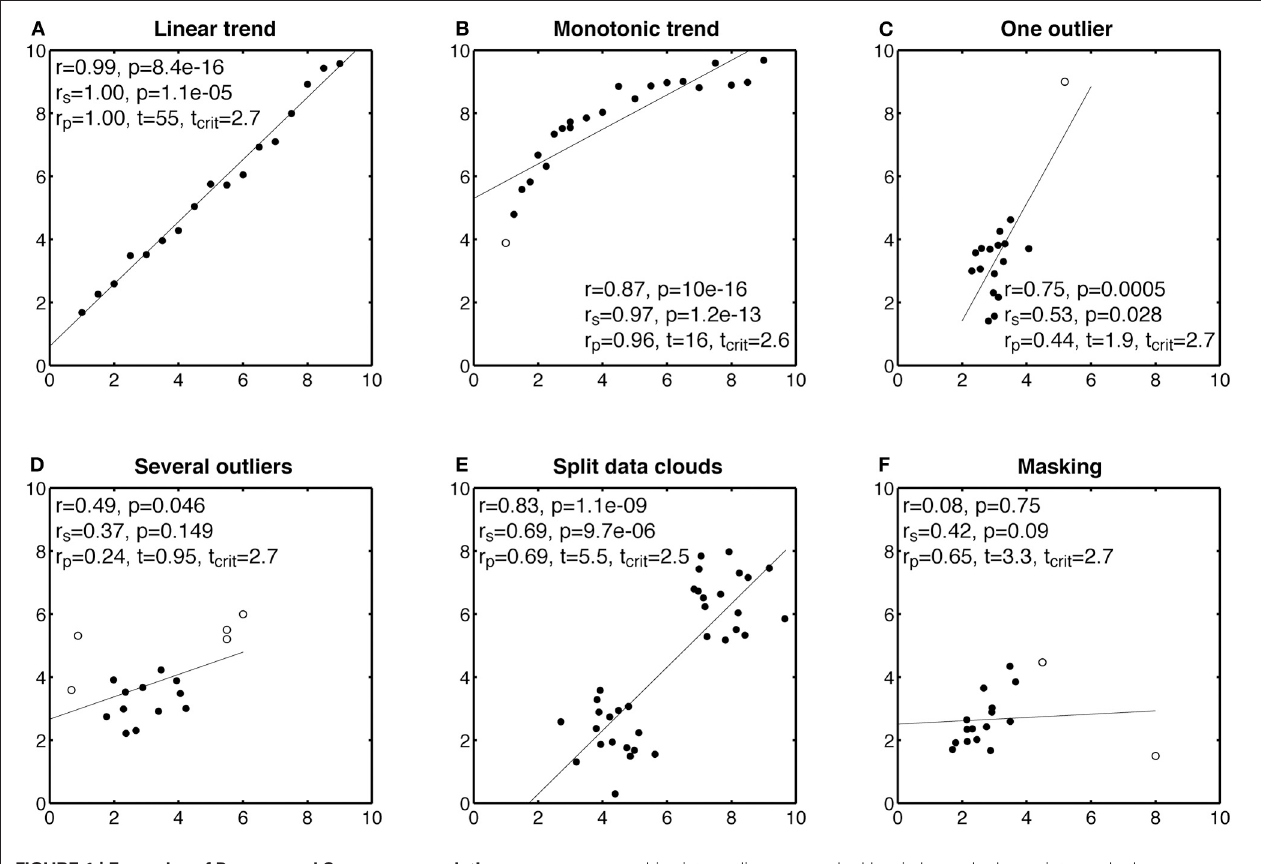
FIGURE 1 | Examples of Pearson and Spearman correlations. In each subplot, r is Pearson correlation, r s is Spearman correlation, and r p is a skipped correlation. Potential univariate and